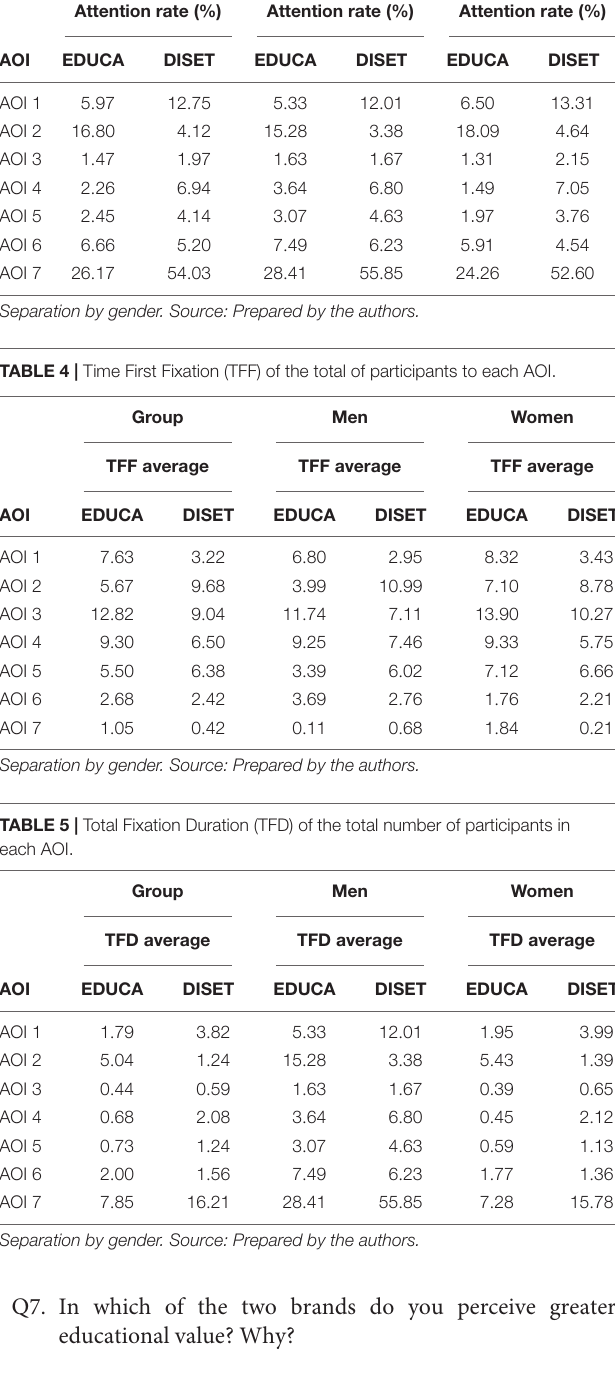
SECTION 3: Perception of Educational Value Through Packaging The two packages are shown to the consumer. Q8. What design (graphic) of the packaging is the most attractive to you? Why?